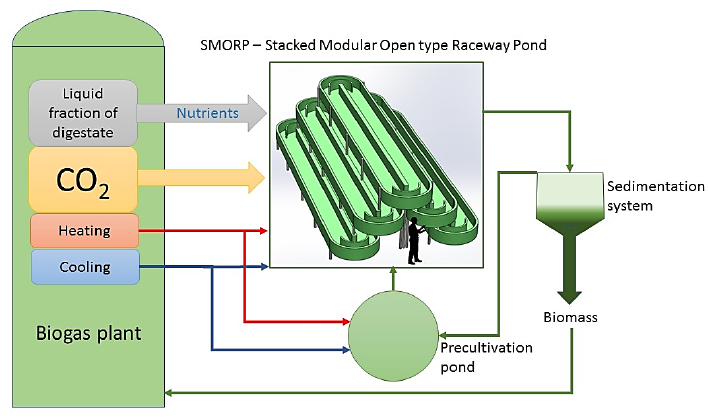
Fig. 1. Integrated concept of the Stacked Modular Open Raceway Ponds (SMORP) in biogas